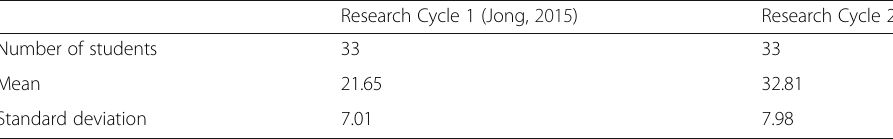
Table 3 Students ’ knowledge test results obtained in Research Cycles 1 and 2 at School A Research Cycle 1 (Jong,